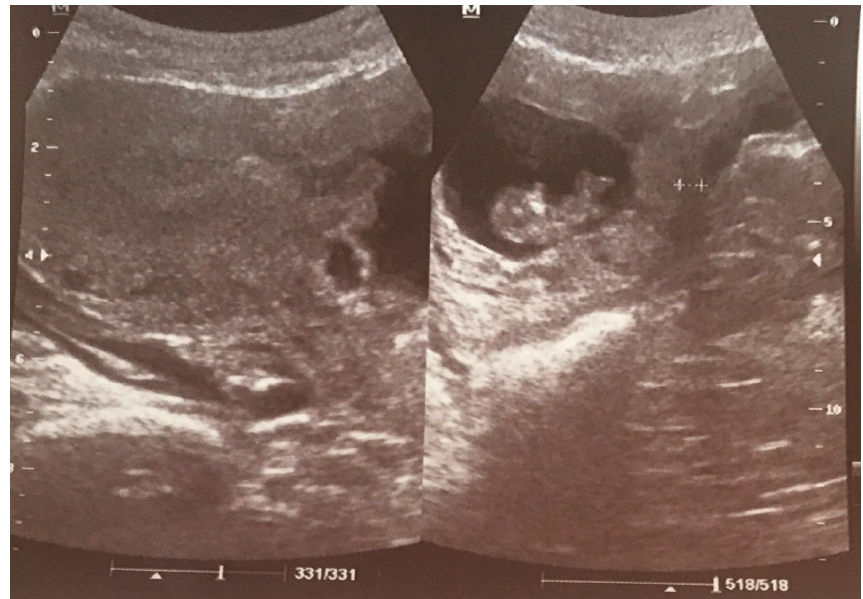
Figure 2. US scan at 10 wks with measurement of the thickness of the scar about 5.4 mm. At 13 wks, the patient was hospitalized in a state hospital due to bleeding from the genital tract. She was discharged without any scan and with a recommendation of iron supplementation. At 14 wks gestation, she was again hospitalized in the same hospital because of cramps in the lower abdominal area. The trophoblast was covering the cesarean scar with possible ingrowth into the urine bladder wall and uterine muscle; the scar thickness was estimated at 2.5 mm in this region. After pharmacological treatment for pain, the patient was dismissed at her own decision. At admission to our Department at 15 wks, the patient reported lower abdominal pains and bleeding. During hospitalization, a diagnosis of CSP was finally confirmed, and explained to the patient with a possible life-threating condition (Figure 3).